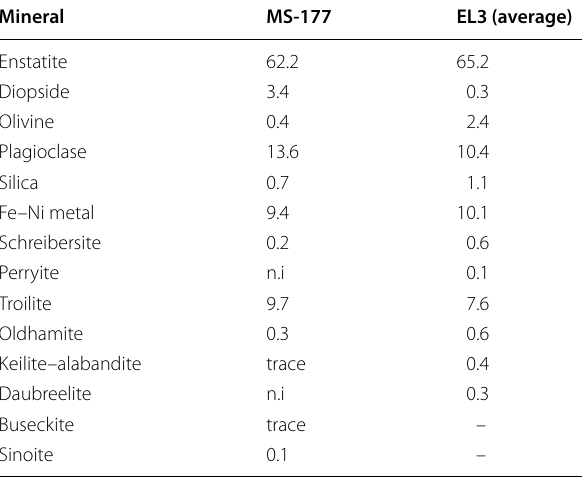
Table 1 Modal composition (vol%) of the MS-177 and average